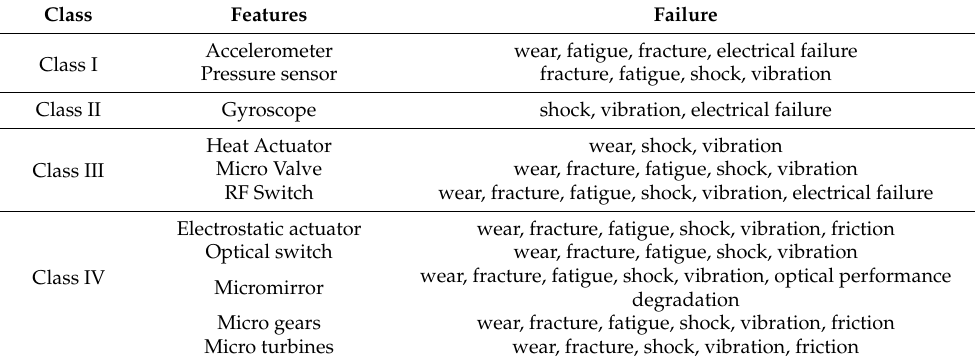
Table 3. Typical failure of MEMS